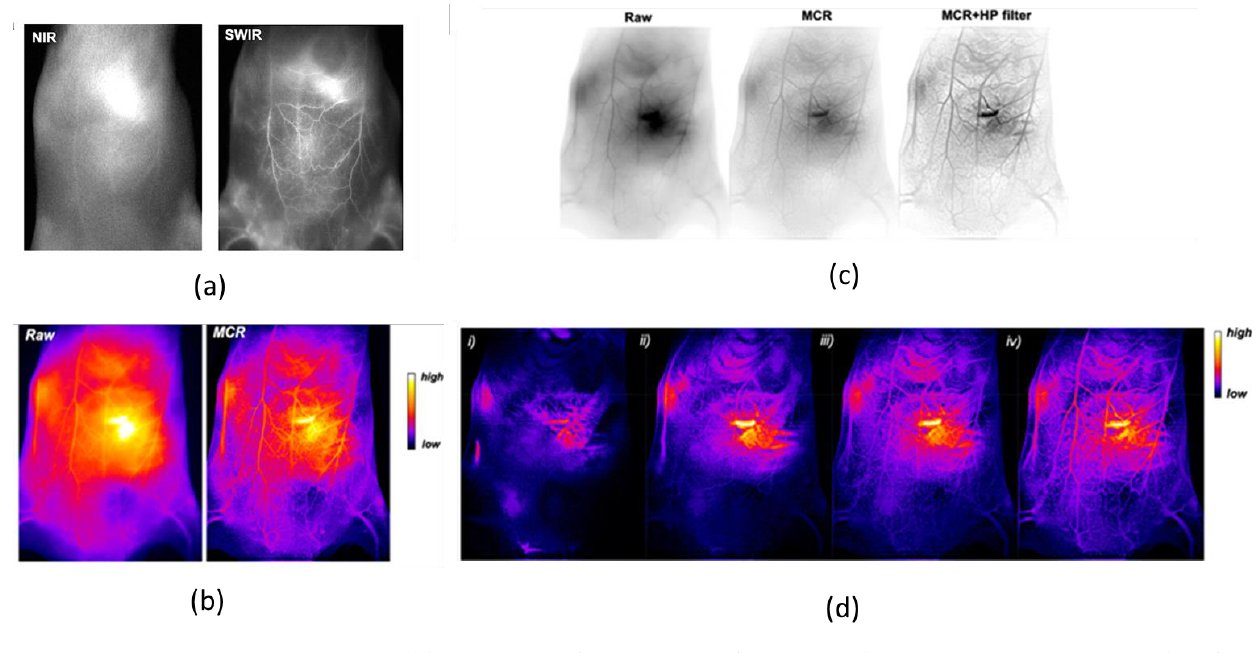
Figure 3. ( a ) Comparison between NIR I bioimaging ( λ exc = 780 nm, λ em > 830 nm) and SWIR bioimaging ( λ exc = 830 nm, λ em > 1250 nm) of mice ventral area 15 min after injection of (MHA/TDT)-AuNCs. ( b ) Comparison between bioimaging (false colors) of the mouse ventral area before (Raw) and after Monte Carlo constrained restoration (MCR) processing. ( c ) In vivo SWIR bioimaging (reverse contrast) of mice vasculature before image processing (Raw) and after MCR and additional high-pass (HP) filtering. ( d ) SWIR bioimages (false colors) after MCR and HP filtering/processing at (i) 1.5 s, (ii) 5 s, (iii) 25 s, and (iv) 65 s after (MHA/TDT)-AuNCs intravenous injection. Adapted with